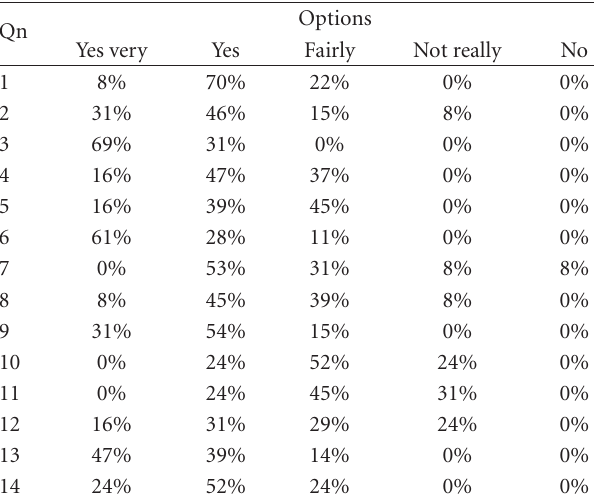
Table 2: Results of user